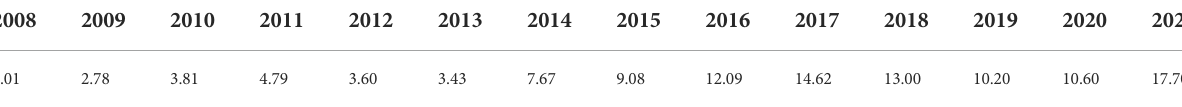
TABLE 1 Pakistan trade de fi cit with China in US$ (source: trademap.org).